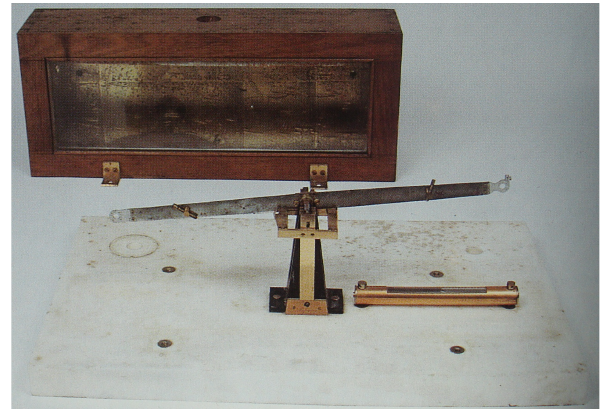
Figure 9. Lloyd’s “vertical force magnetometer” (or “balance mag- netometer”) used in Secchi’s magnetic observatory (Astronomical Observatory Museum,